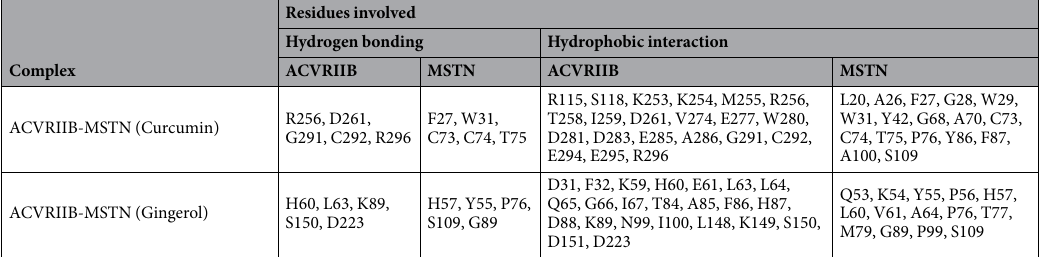
Table 2. Residues involved in the binding of MSTN (in the presence of curcumin and gingerol) to its receptor